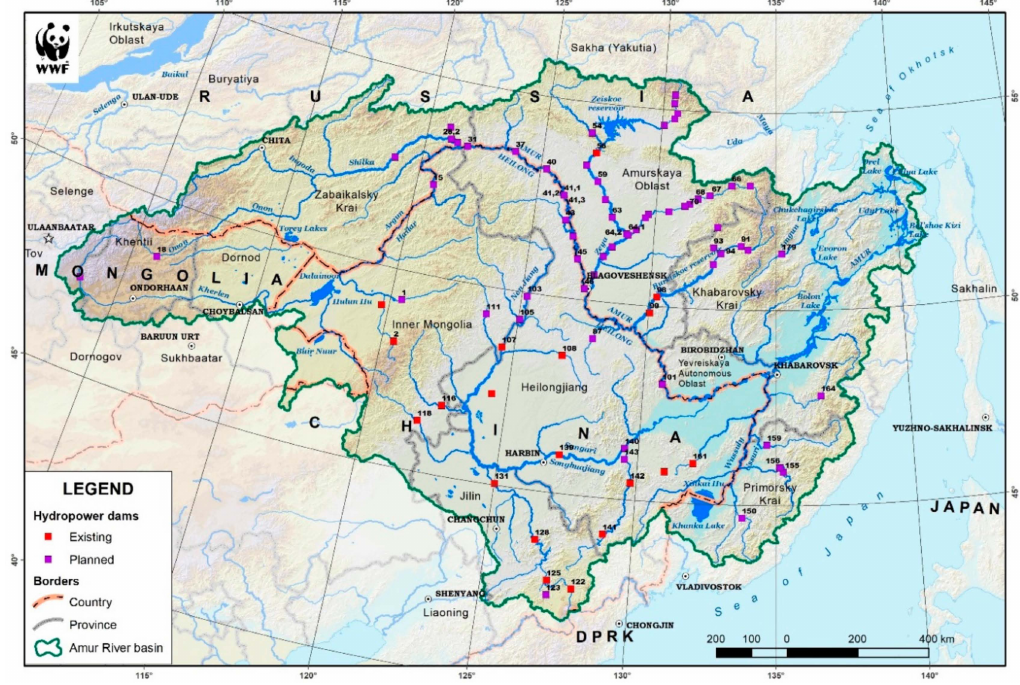
Figure 2. Locations of the existing and potential dams in the Amur River basin. ©